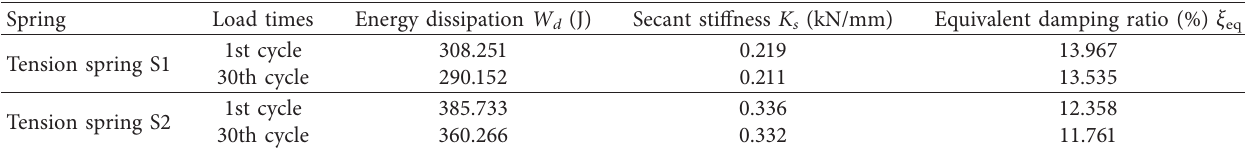
Figure 9: Comparison of hysteresis curves of the fatigue test. (a) Hysteresis curve of SCVF brace with spring S1. (b) Hysteresis curve of SCVF brace with spring S2. Table 9: Mechanical parameters under 5mm deflection of the friction